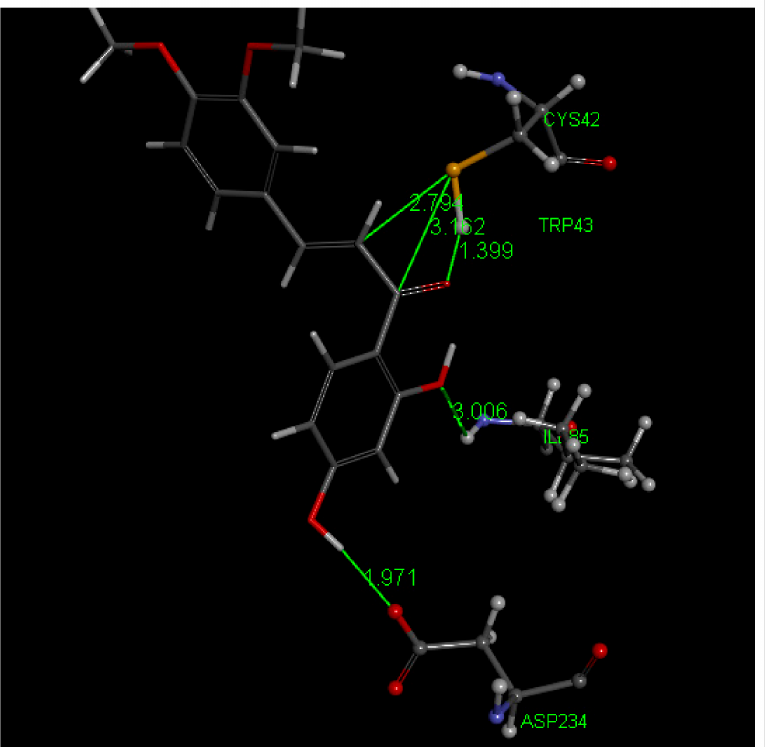
Figure 22. DHDM pose 2 from docking after calculate binding energy. The potential reactivity of S(thiolate) towards the ethenyl α carbon is confirmed by S–C distance of 2.794 Å, and shortening of H bond between H[(Cys42)] and O(carbonyl), 1.399 Å. H bonds involving chalcone and the two amino acids, Asp234 and Ile85, are also confirmed. Omitted for clarity is a H bond between Trp43 and O(carbonyl) of